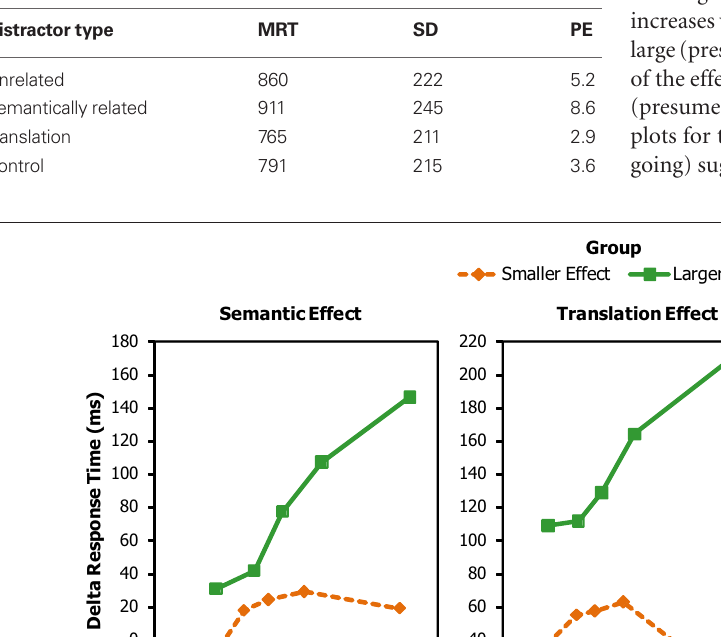
Table 2 | Mean response time (MrT, in milliseconds), standard deviations (SD), and percentage error (Pe) per distractor type.